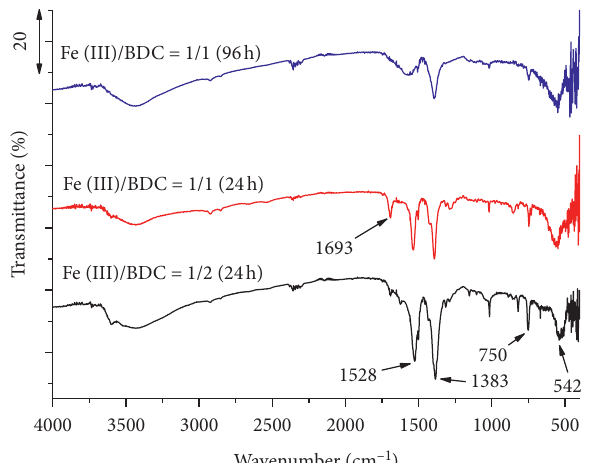
Figure 7: FT-IR spectra of iron (III) benzene dicarboxylate samples synthesized at 150 ° C with different reaction times and different Fe (III)/ BDC molar ratios.